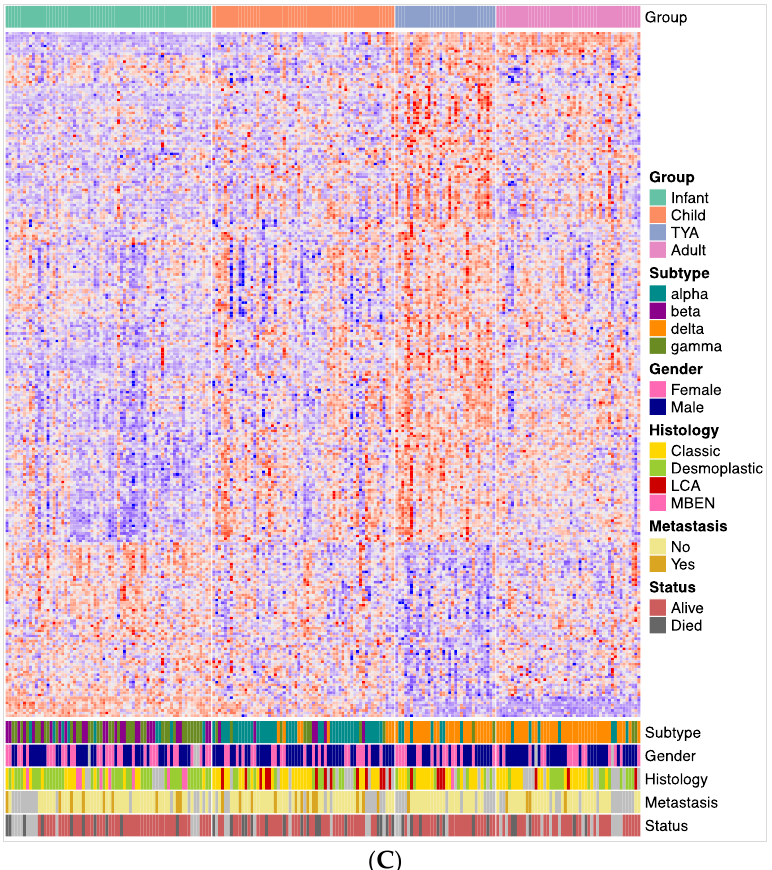
Figure 2. Comparison of differential expression patterns of TYAs in medulloblastoma molecular subgroups. ( A ) Summary of gene ontology (GO) biological processes derived from the enrichment analysis of up-regulated genes in teenagers and young adults (TYA) medulloblastoma. X- and Y-axes represent a two-dimensional annotation space derived from a multi-dimensional scaling procedure used on a matrix of GO terms’ semantic similarities. By employing this visualisation method, similar biological categories will cluster together. Bubble colour represents the P -value obtained from GO enrichment analysis (value) and bubble size relates to the frequency of GO terms in the GO annotation database (log_size). ( B ) Rank-rank hypergeometric overlap (RRHO) maps comparing pairs of medulloblastoma (MB) subgroups with expression differences between TYAs and other age groups. Each pixel represents the overlap between the TYA transcriptome of two MB subgroups with the significance of overlap ( − log 10 ( p value) of a hypergeometric test; step size 200) colour coded. G3 and G4 represent Group 3 and Group 4 MB subgroups. Schematic indicating interpretation of RRHO test plots (bottom-left). A hot spot in the bottom-left corner indicates overlap in genes up-regulated in TYA in both MB subgroups 1 and 2. A hot spot in the top-right corner indicates overlap in genes down-regulated in TYAs in both MB subgroups 1 and 2. A hot spot in the top-left indicates overlap in genes up-regulated in TYAs in MB subgroup 2 and down-regulated in TYAs in MB subgroup 1. A hot spot in the bottom-right indicates overlap in genes down-regulated in TYAs in MB subgroup 2 and down-regulated in TYAs in MB subgroup 1. ( C ) Heatmap plot showing expression of genes that are significantly altered between TYAs and other age groups in SHH tumours. Row represents a gene, and the column indicates the sample. The normalised expression value of each gene is indicated by colour intensity, with red/blue representing high/low